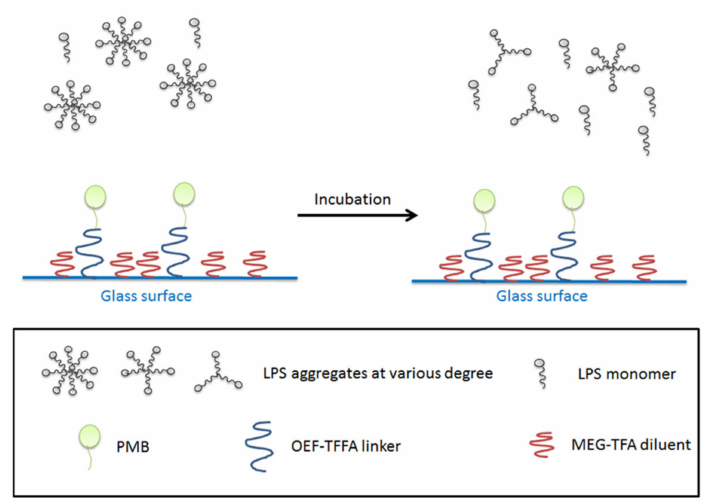
Figure 6. LPS aggregates before incubation with PMB-modified glass beads ( left ), after incubation ( right ). The majority of LPS exists in form of monomers or aggregates with less LPS molecules per unit. The bottom panel shows the legends being used in the